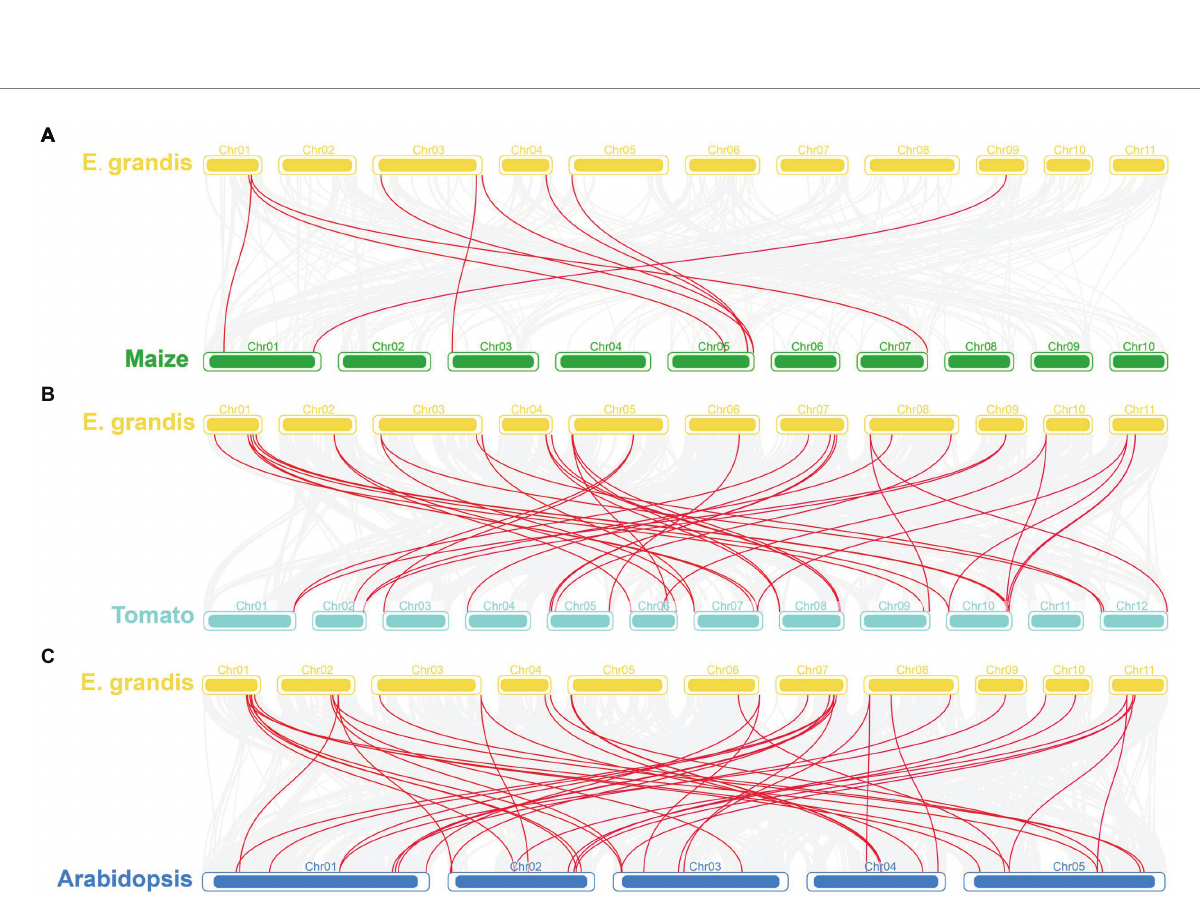
FIGURE 2 Synteny analysis of GLK genes in different plants. Synteny analyses of GLK genes between E. grandis and maize (A) , tomato (B) , and Arabidopsis (C) . Red lines indicate the homologous GLK genes between E. grandis genome and other plant